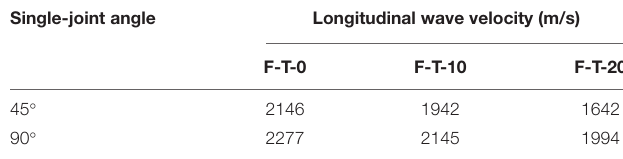
TABLE 1 | Wave velocity changes of single-joint rocks under different F-T cycles.